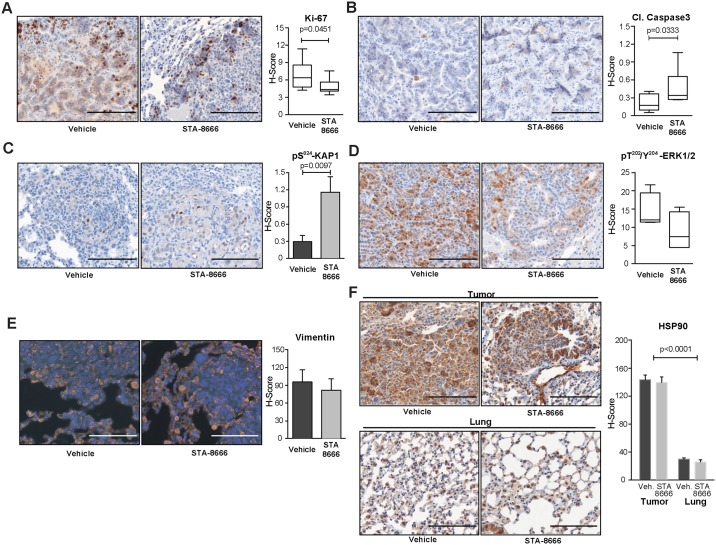
Signaling consequences of STA-8666 treatment.A.-F. Left, Representative images and right, quantification of IHC or immunofluorescence for Ki-67 (A), cleaved caspase 3 (B), pS824-KAP1 (C), pT202/Y204-ERK1/2 (D), vimentin (light red) and DAPI (blue) (E) and HSP90 (F). Magnification: 20x. Scale bars: 75 μm, except for vimentin, where scale bar is 40 μm.